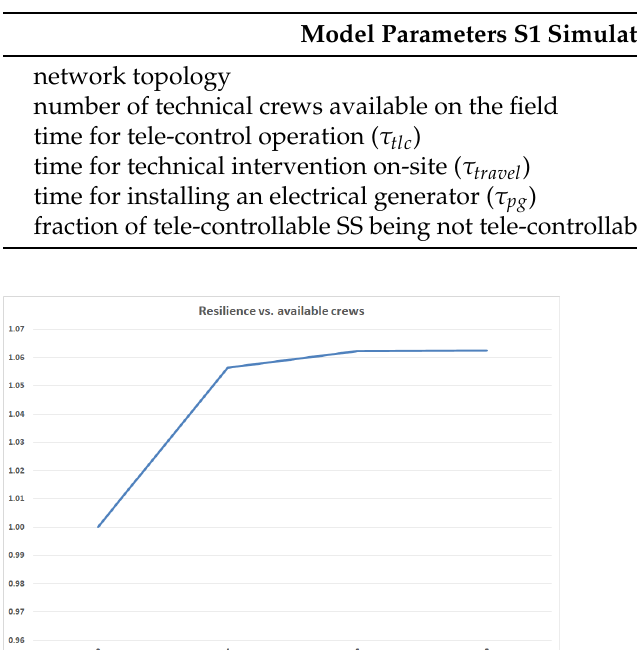
Table 2. Parameters used for S1 simulations.